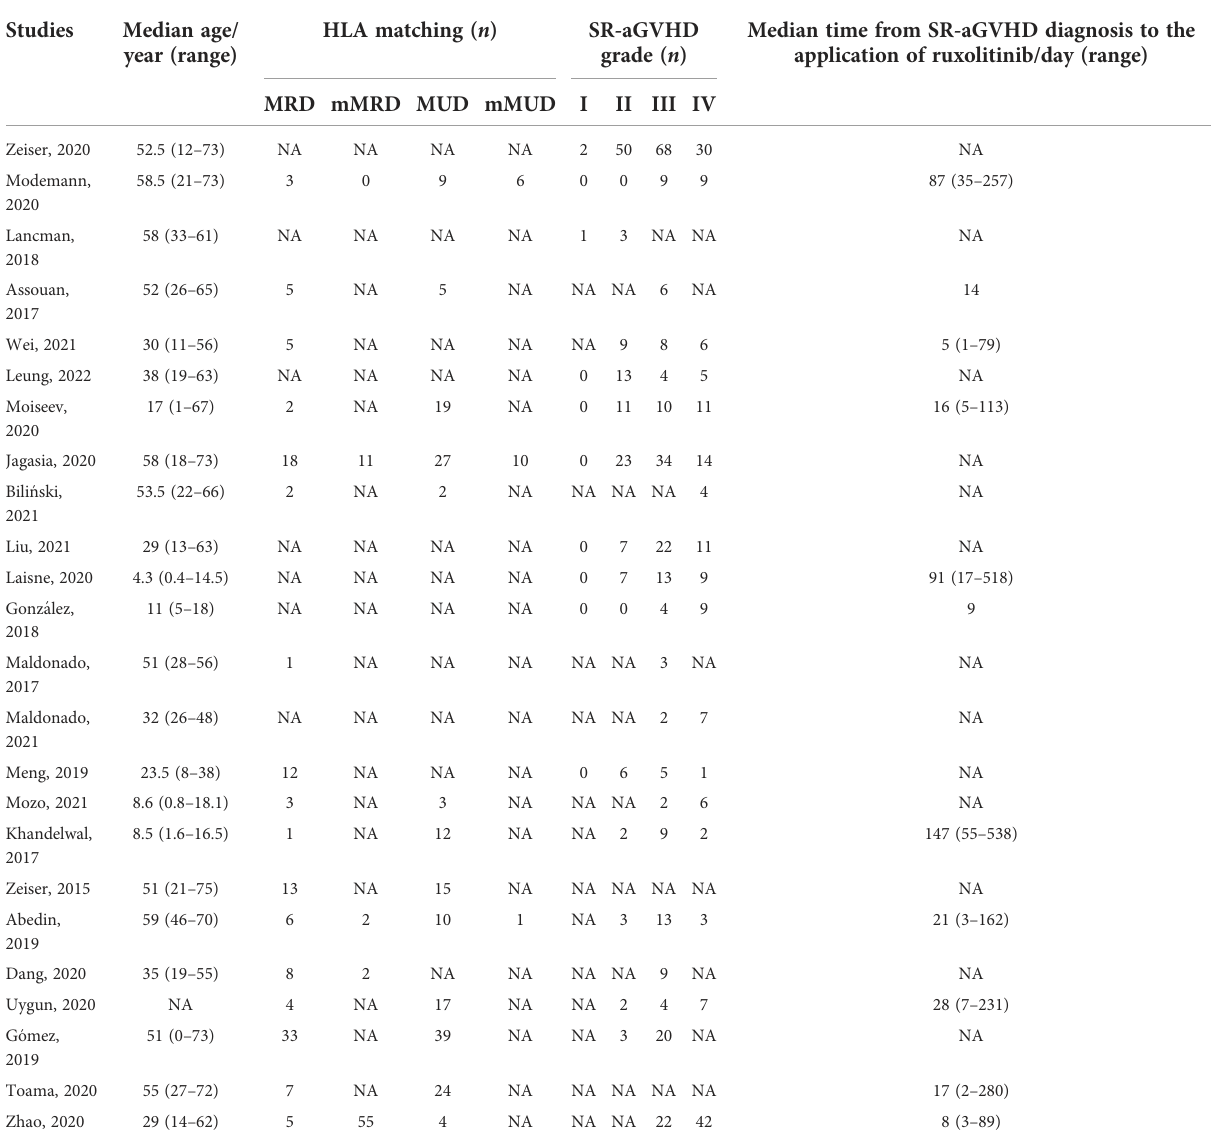
TABLE 1 Characteristics of 24 included studies (SR-aGVHD) * .